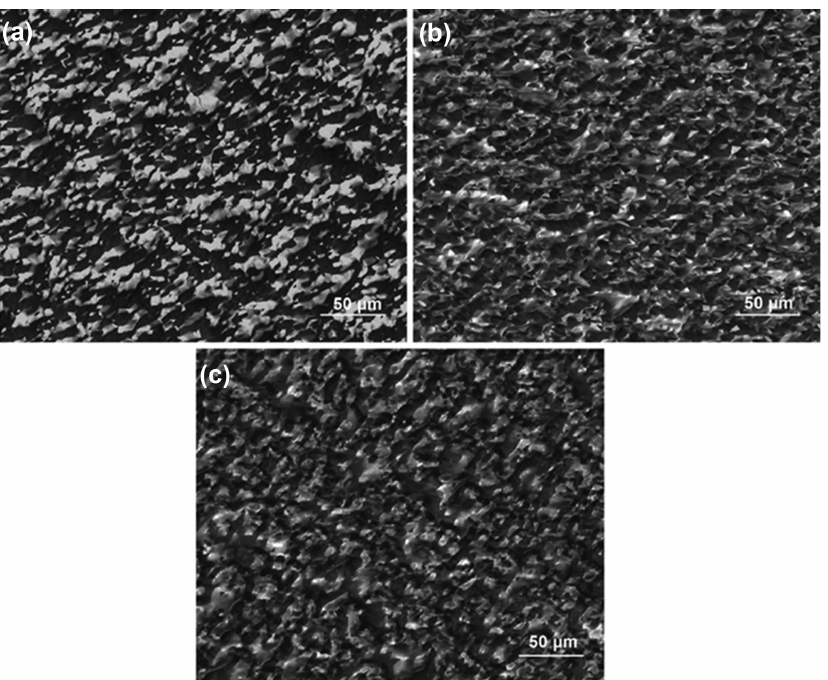
Figure 7: Scanning electron micrograph of the MgAl 2 O 4 -Y 3 Al 5 O 12 eutectic after creep deformation at various temperatures. For a directionally solidified MAS-YAG structure: (a) at 1,500°C, (b) at 1,600°C, and (c) at 1,700°C. The bright areas are Y 3 Al 5 O 12 and the dark areas are MgAl 2 O 4 .